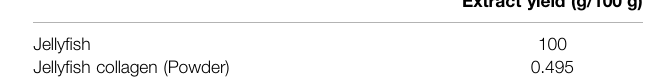
TABLE 1 | Proximate composition of jelly fi sh. Component Wet weight (%)